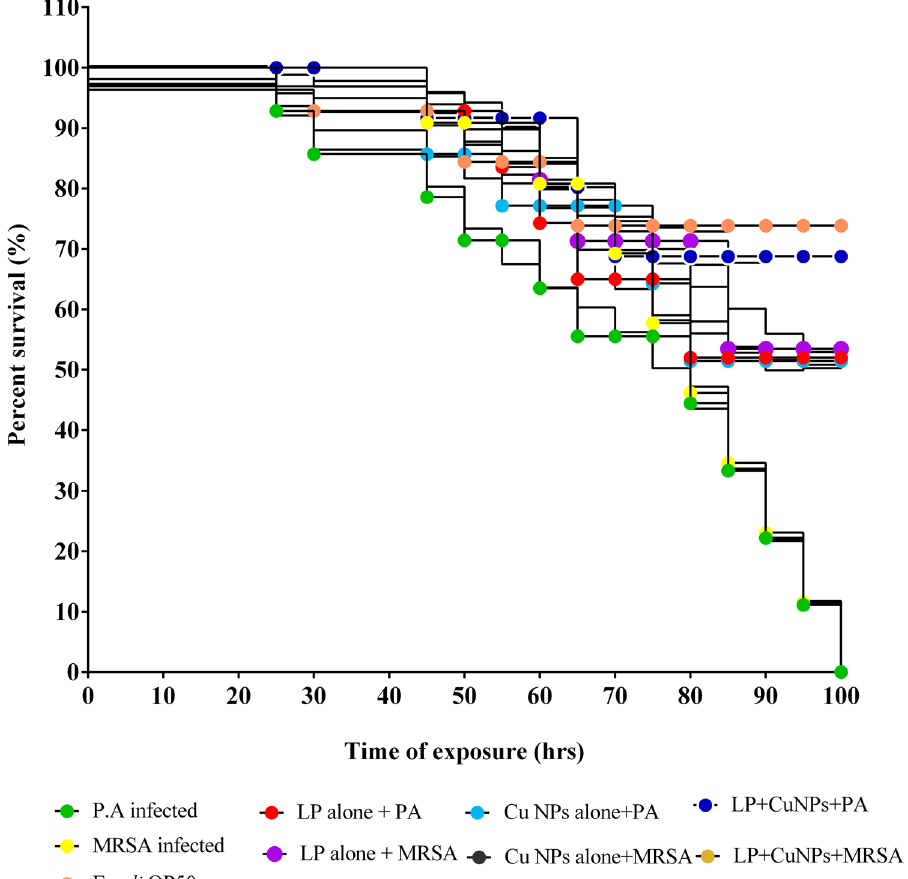
Figure 17. Kaplane-Meier survival plots from C. elegans feeding on P. aeruginosa , MRSA upon the treatment of LP alone, Cu-NPs alone, LP + Cu-NPs. All data points represent the mean ± SD from at least three independent